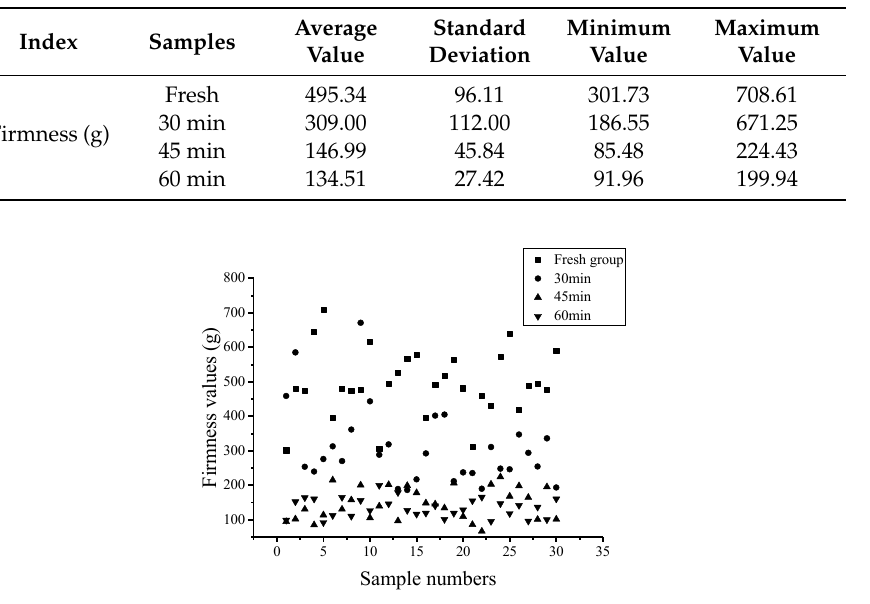
Figure 10. Scatter plot of the distribution of the firmness values of the Nanguo pears.